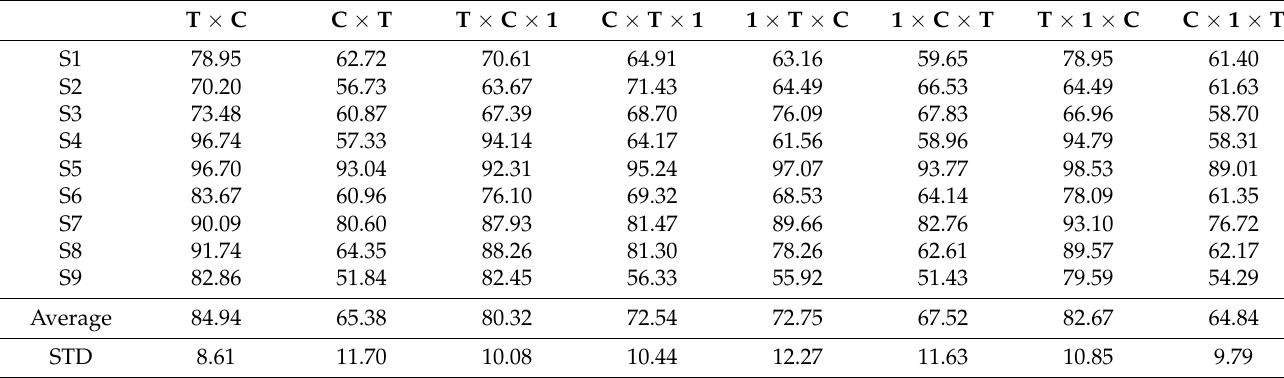
Table 2. Subject-Based and Average Accuracy Values of BCI-IV-2B.